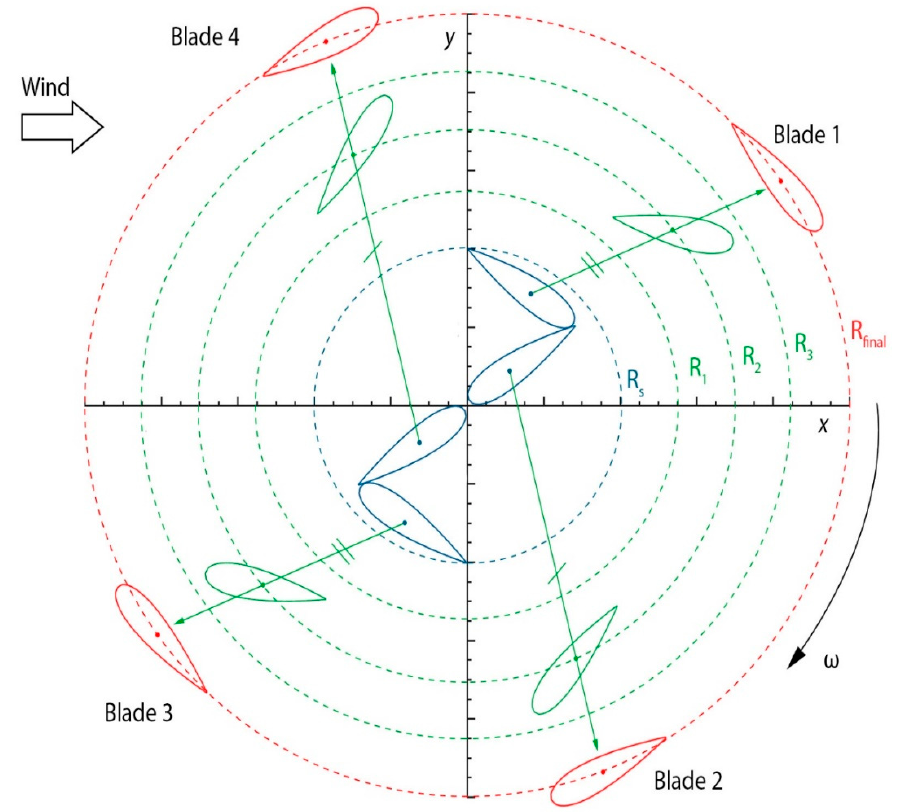
Figure 3. Schematic showing an arbitrarily chosen initial (blue) and final (red) blades’ positions, along with the resulting blades’ centers paths (green).